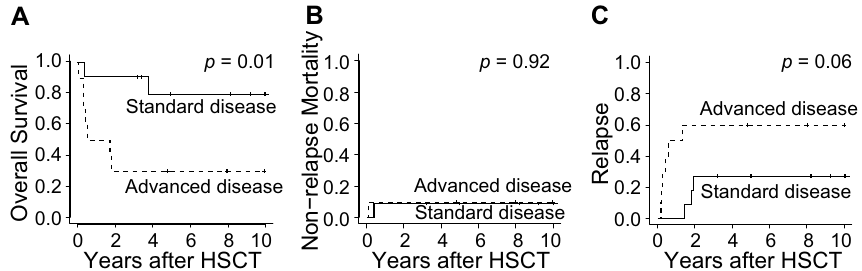
Figure 3. Comparison of post-HSCT prognosis according to the disease risk at HSCT. Comparison of prognosis between standard disease (HSCT at CR1/PR1) and advanced disease (HSCT at CR2/PR2 or at non-